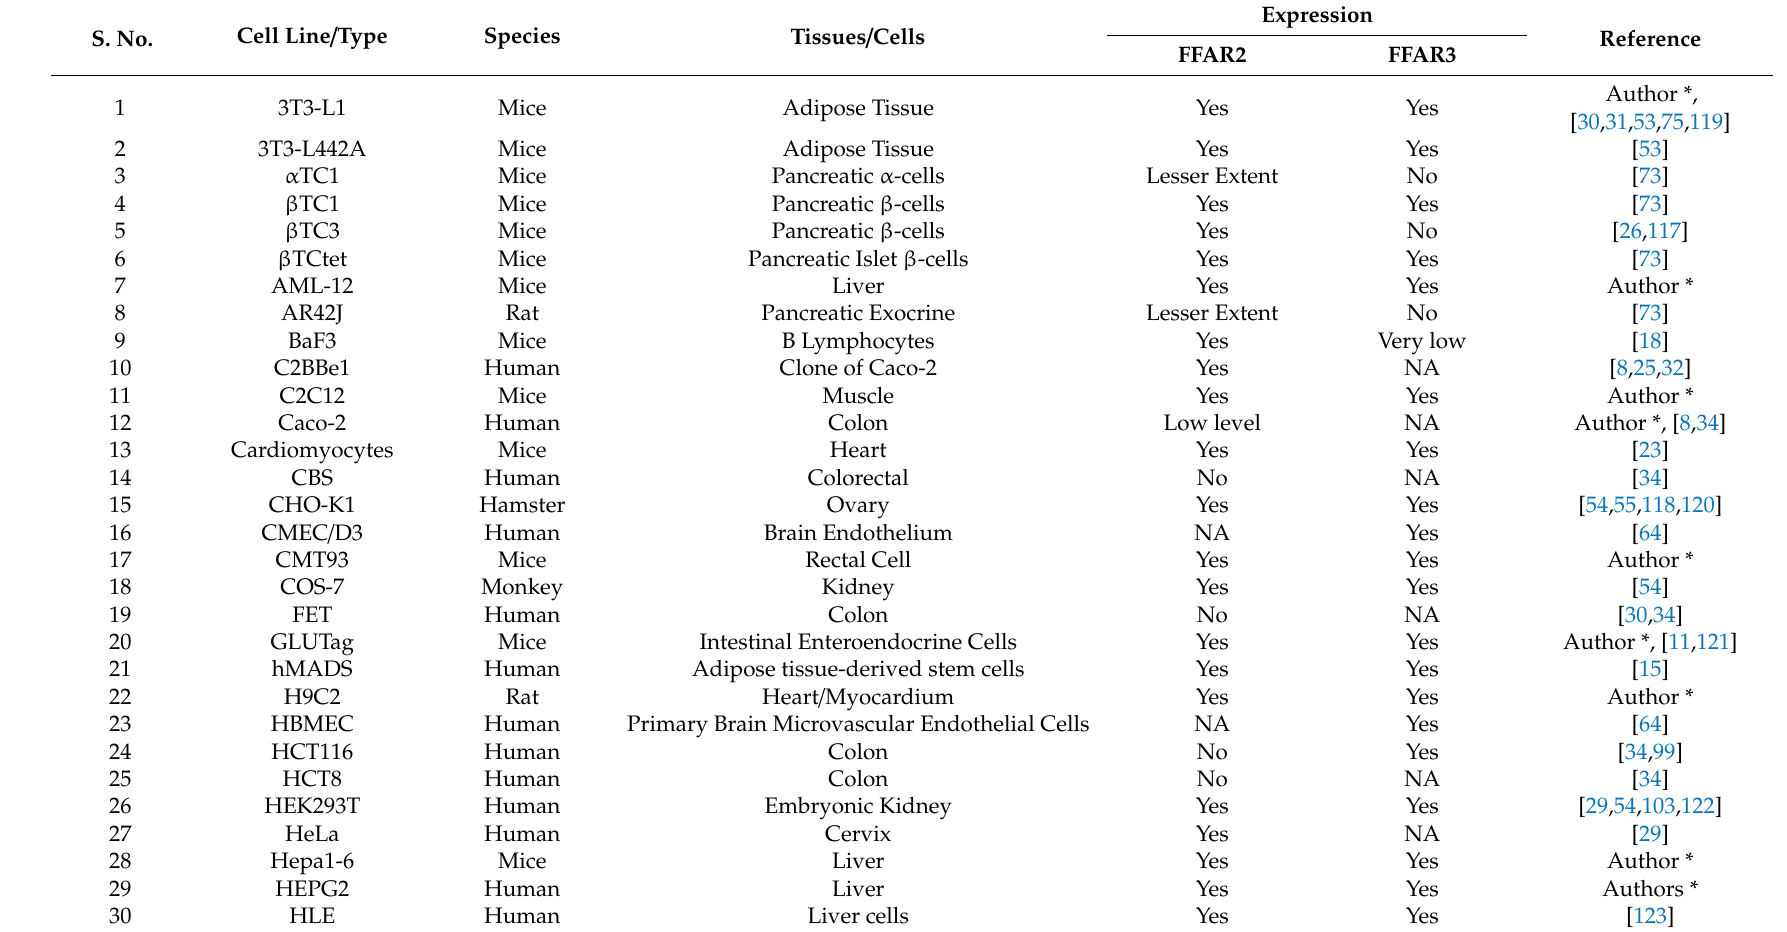
Table 1. Expression of FFAR2 and FFAR3 in di ff erent species’ cell